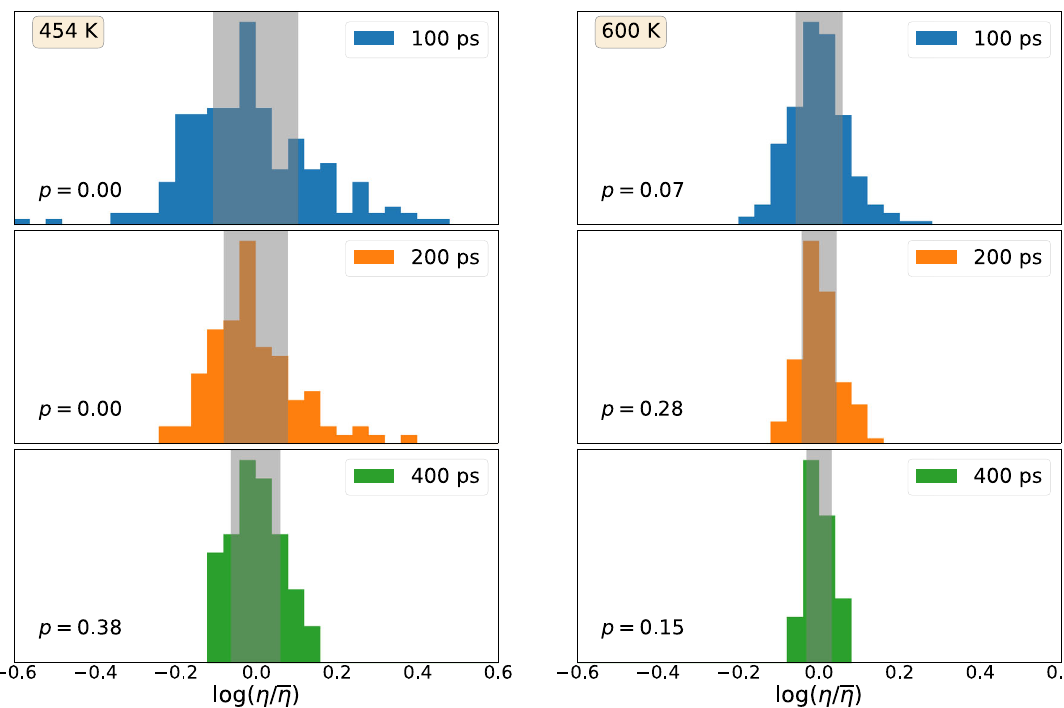
Fig. 5 Normalized distributions of the logarithm of the shear viscosities, log( η ). The results are estimated over multiple MD segments (blue: 100-ps; orange: 200-ps; green: 400-ps) extracted from a 20-ns trajectory at 454 K (left) and 600 K (right). The reported data are referred to the average, η . We remind that the absolute error on log( η ) is the relative error on η . The shaded area denote the average standard deviation of the shear viscosities, as estimated by cepstral analysis within each individual